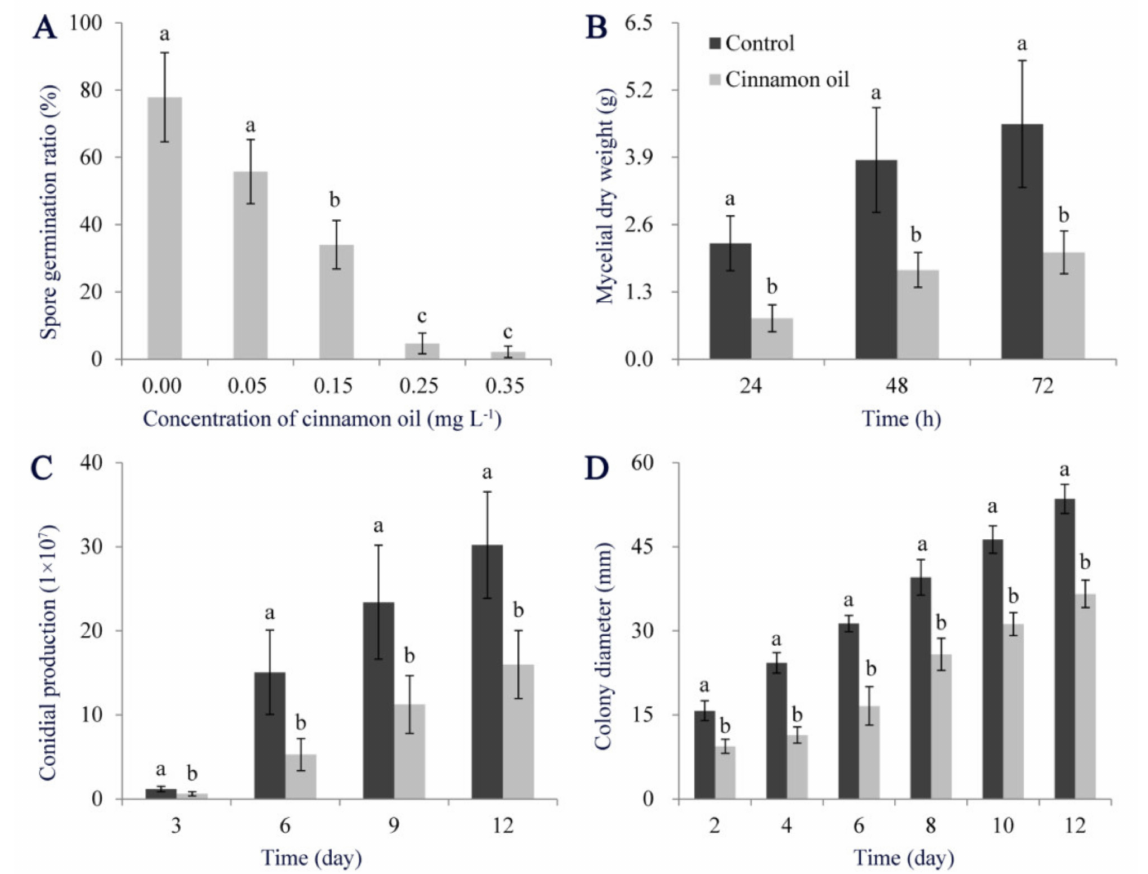
Figure 1. Effects of cinnamon oil on the development of P. expansum. Effects of cinnamon oil with different concentrations on spore germination ratio of P. expansum after 12 h of culturing ( A ). Effects of cinnamon oil with a concentration of 0.25 mg L − 1 on hyphae production ( B ), sporulation ( C ), and colony expansion of P. expansum ( D ). Bar represents the standard deviation of the means of three independent experiments. Lower-case letters indicate significant differences at p < 0.05 at each time